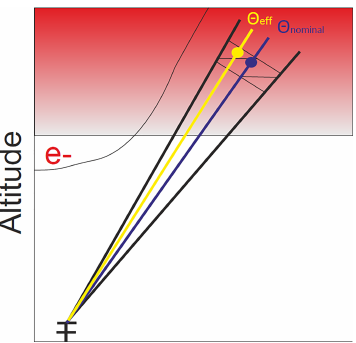
Figure 9. Schematic illustration of a tilted Saura beam (black) in a stratified atmosphere. The reddish area symbolizes an increas- ing electron density in the stratified medium. The observed tilted beam volume is not equally filled with larger electron density at the nearer-zenith beam edge. This results in a shifted beam pointing angle (yellow) relative to the main beam